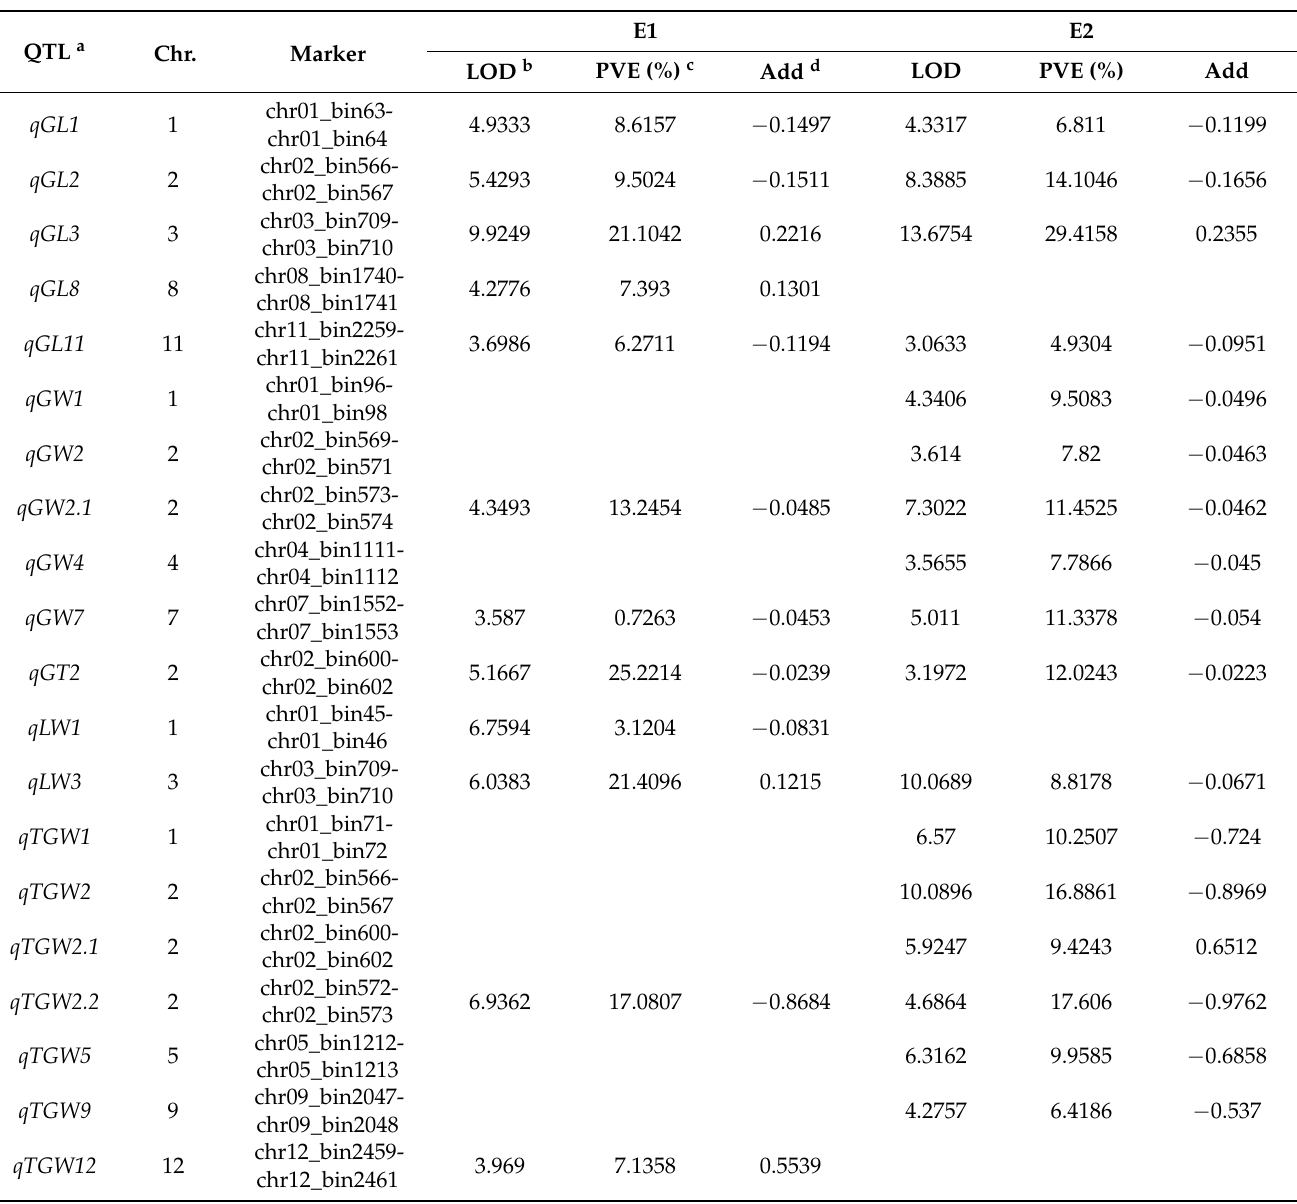
Table 3. Detected QTL affecting GL, GW, GT, LW, and TGW traits using RILs population across two